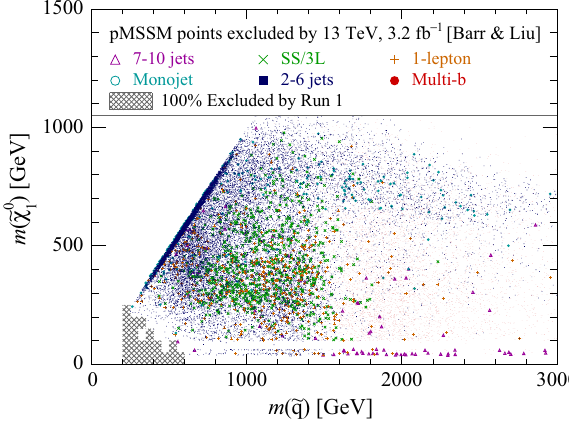
Fig. 2 Same plot as Fig. 1a but projected into the squark–LSP plane. Here m ( ˜ q ) denotes the lightest squark of the first or second